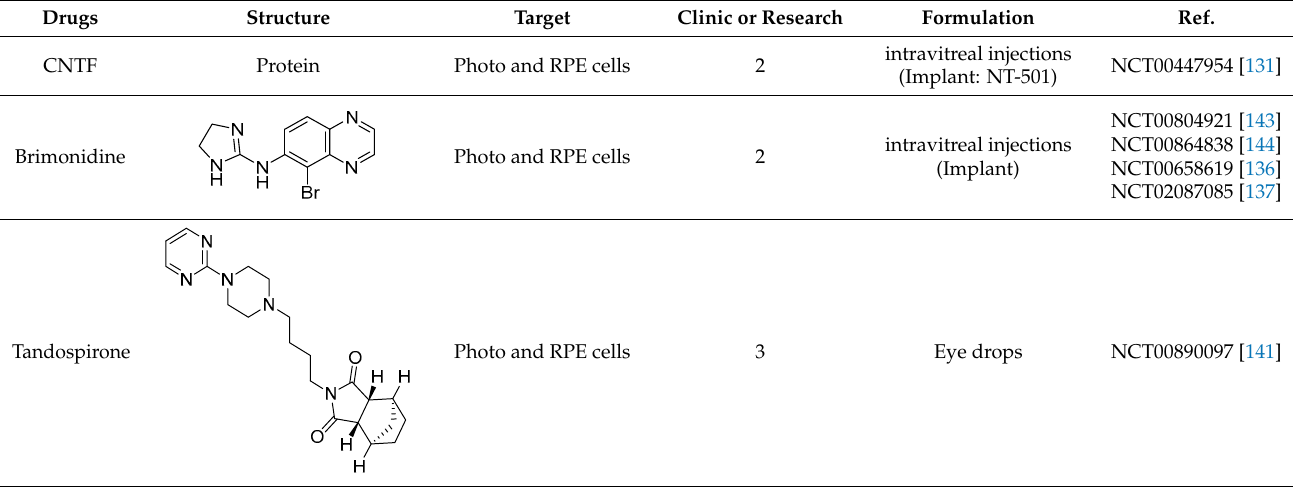
Table 6. Drugs targeting neuroprotection.